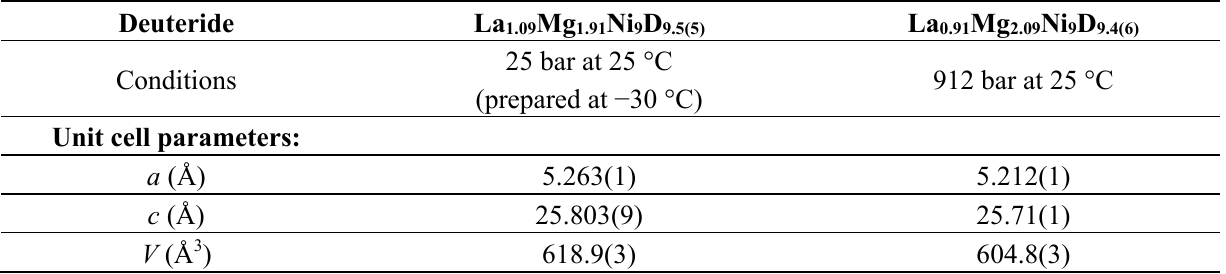
Table 2. Crystal structure data for the deuterated La 1±0.1 Mg 2±0.1 Ni 9 alloys ( PuNi 3 type, sp.gr. R 3(cid:3364) m ) from the Rietveld refinements of in situ neutron diffraction